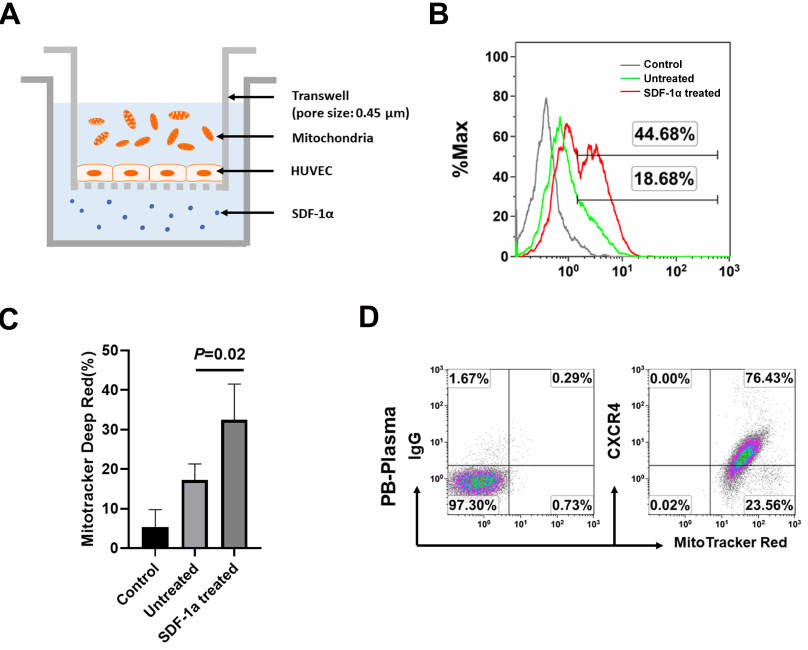
Figure 3. Chemotaxis of plasma mitochondria by transwell migration assay. ( A ) Experimental design of transwell migration assay. Human umbilical vein endothelial cells (HUVEC) were seeded in the top chamber at 1 × 10 5 cells / mL. The chemoattractant SDF-1 α was added into the bottom chamber. ( B ) Flow cytometry showed the migration of mitochondria into the bottom chamber. After incubation for 16 h, flow cytometry demonstrated the migration of MitoTracker Deep Red-labeled mitochondria was increased in the presence of treatment with SDF-1 α (red histogram), relative to the absence of SDF-1 α (green histogram). Unlabeled mitochondria served as negative control (grey histogram). The data were representative of three experiments with similar results. ( C ) Improve the migration of mitochondria after the treatment with SDF-1 α ( N = 6). ( D ) Flow cytometry showed the expression of CXCR4 on PB-derived mitochondria ( N = 4). Isotype-matched IgG served as